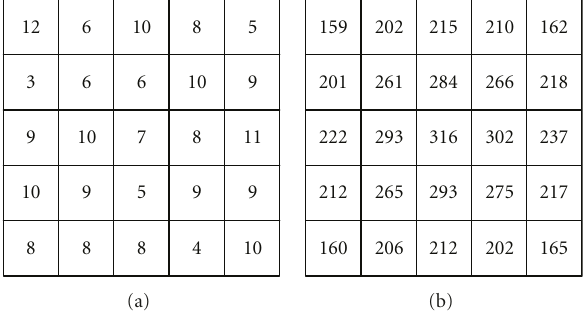
In the second step, local tra ffi c demand on each mesh router, denoted by D ( j ), j = 1 ··· N r , is calculated.